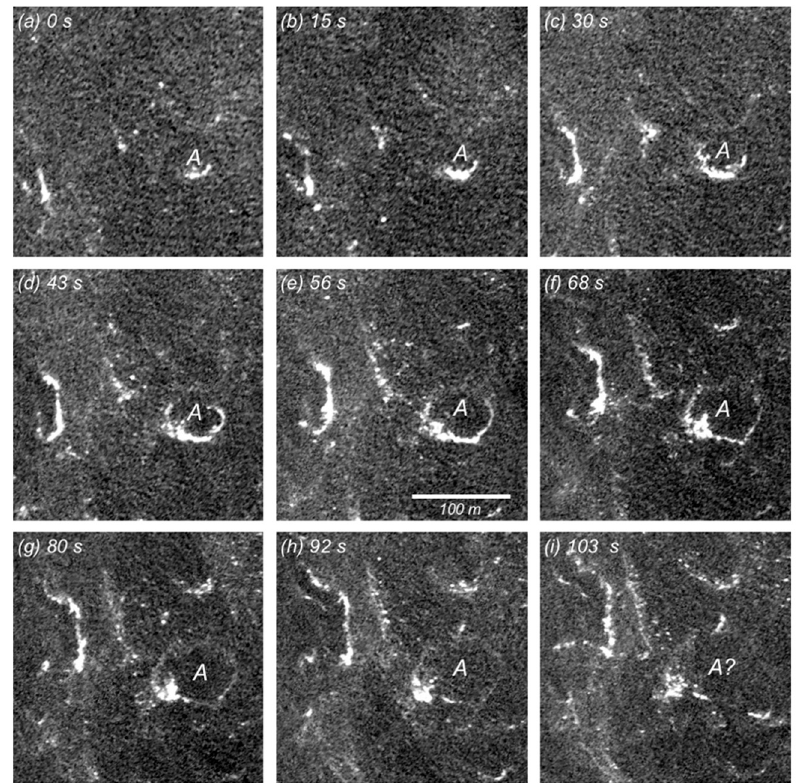
Figure 4. Example of the evolution of a boil (feature “A”) over time. ( a – i ) Approximate Lagrangian views of the same area of water surface, as captured in nine consecutive looks from the mid-flood case (Table 1, August 22). Times shown are relative to look 1; data are from the panchromatic band. Each panel has a size of 256 m by 256 m, which is the same size as the interrogation window used in the PIV calculations. Local water depth is 36 m.